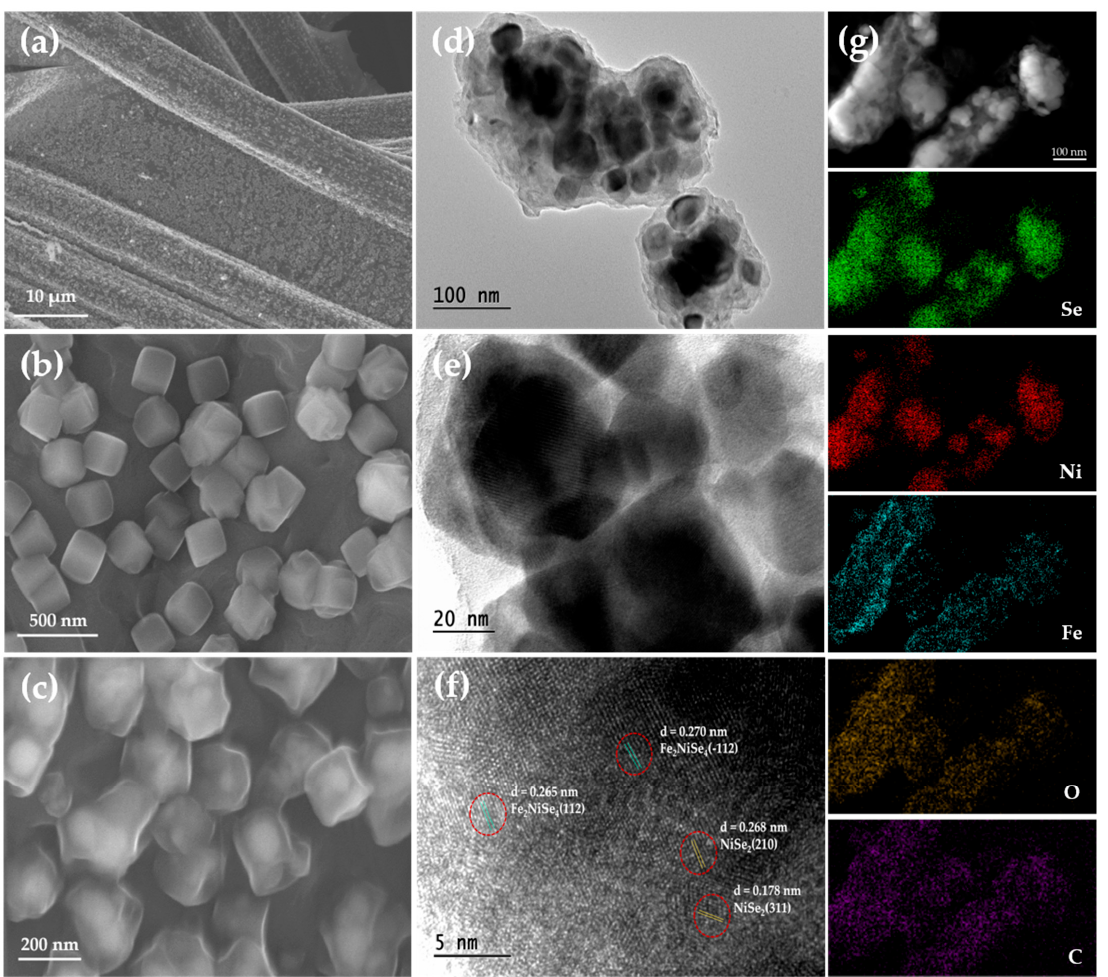
Figure 2. Morphology and structure characterizations. ( a , b ) FESEM images of PBA/CFP: ( c ) FESEM, ( d , e ) TEM, and ( f ) HRTEM images of NiFeSe/CFP. ( g ) HAADF-STEM and elemental mapping images of selected NiFeSe NCs.